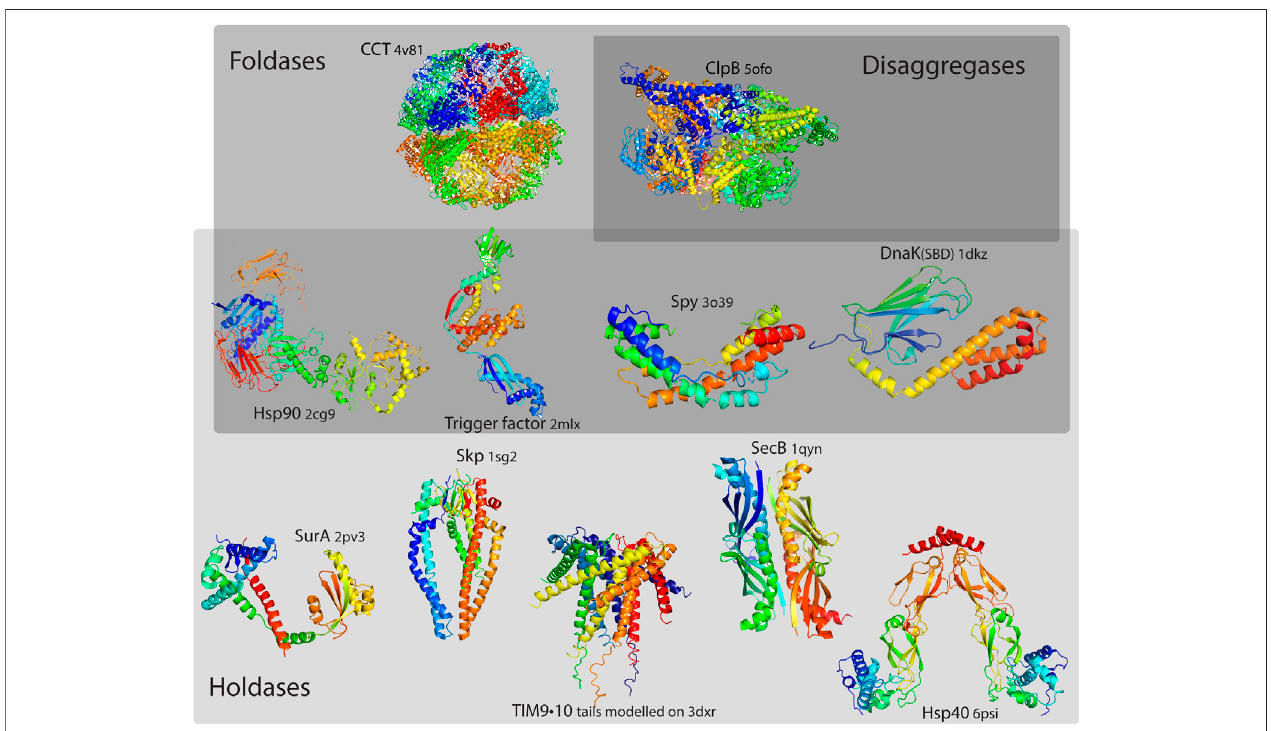
FIGURE1| Selectedexamplesofmolecularchaperonesclassi fi edbytheirchaperoningproperties.Whileallchaperonescouldbeconsideredasholdases,withthe function of binding its structurally unstable client and preventing its aggregation, foldases have an additional function of assisting the client protein folding to its native state, and disaggregases have an additional function in dissociating protein aggregates. Certain chaperones could have multiple functions. Delineating strictly between thesefunctionsishardlypossible,aschaperonesmayhave differentfunctionsdependingontheirclients; thus,thefrontiersarenottobeseenasstrictboundaries.